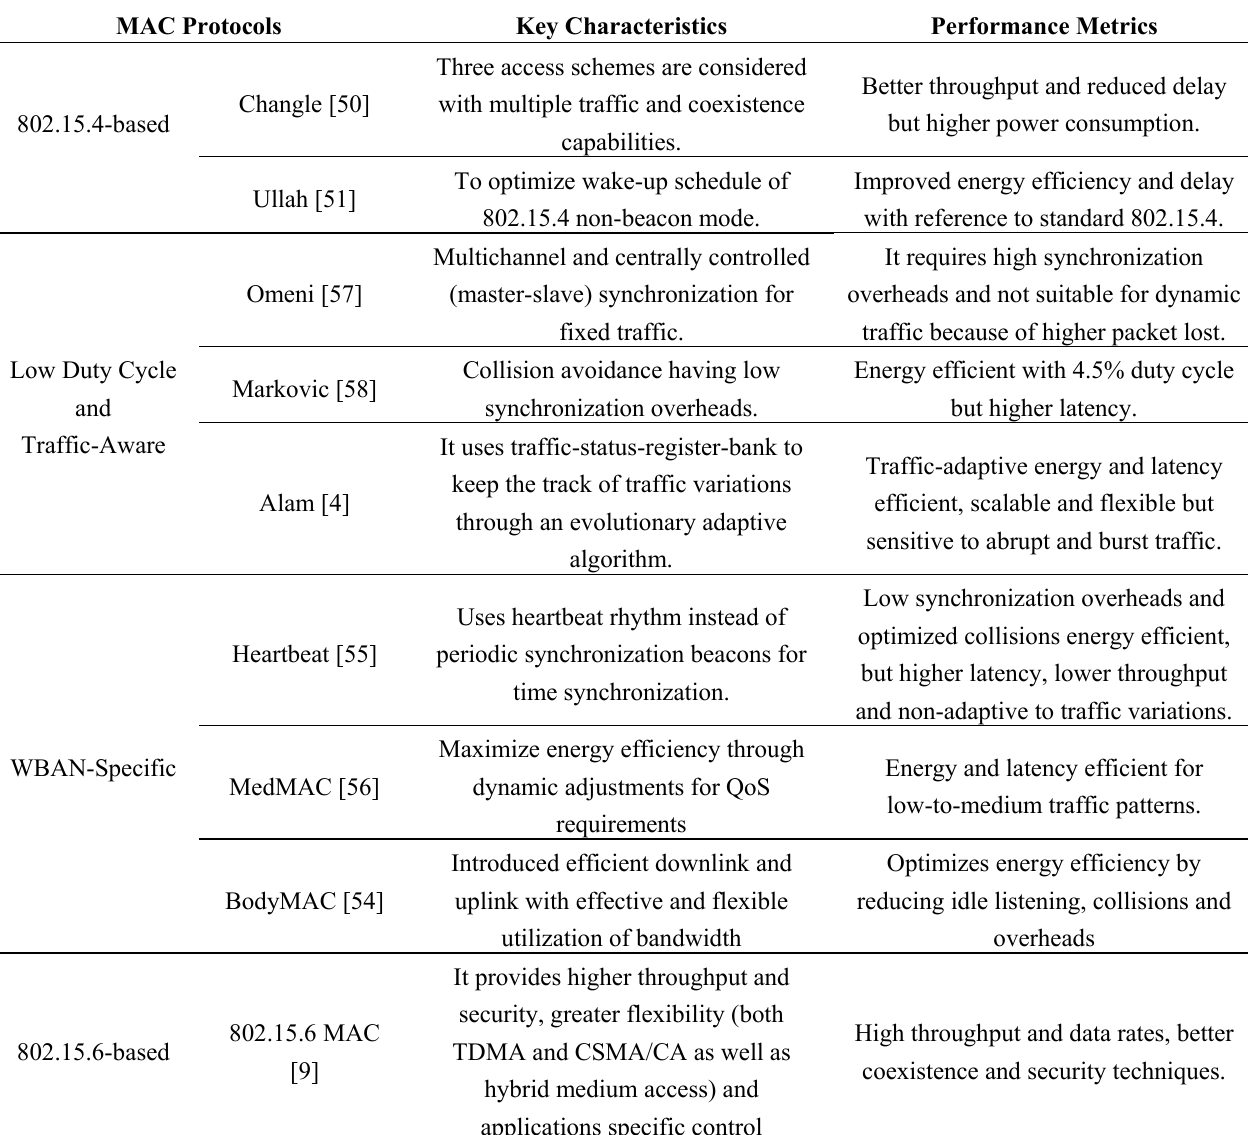
Table 9. Summary on existing major WBANs MAC protocols.